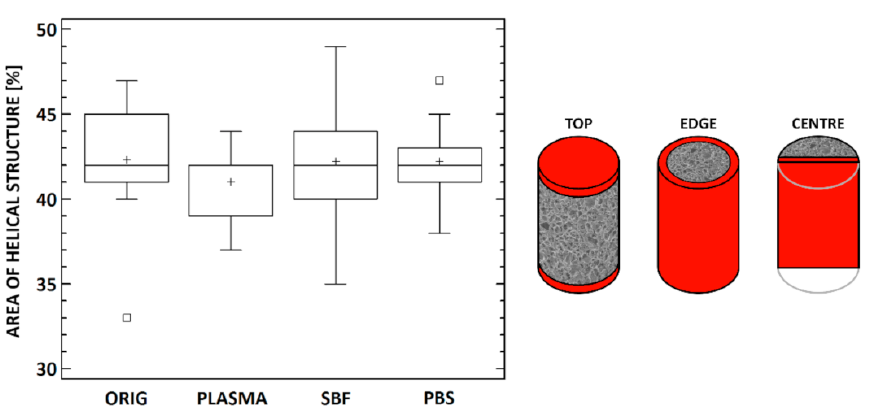
Figure 6. Left : The area of the helical collagen structure determined via the FTIR analysis for the samples prior to exposure (ORIG) and following exposure to the media: blood plasma (PLASMA), simulated body fluid (SBF), and phosphate buffer saline (PBS). No statistically significant differences were detected (Kruskal–Wallis test with the Bonferroni procedure, 0.05 , n = 10). Right : Scheme of the positions as evaluated via FTIR. The thickness of layer evaluated by FTIR is up to approximately 10 µ